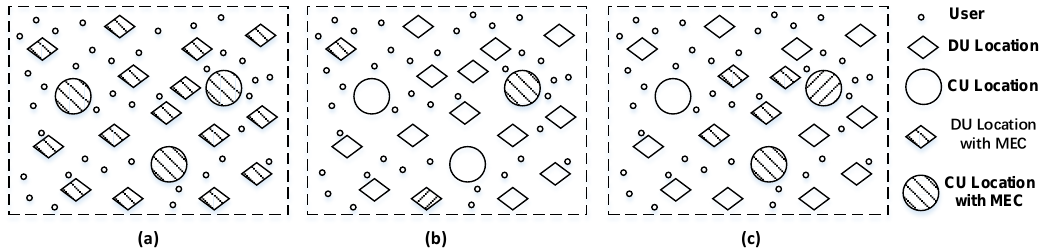
Figure 1. Different deployment solutions of mobile edge computing (MEC) servers in cloud radio access network (C-RAN) ( a ) Full deployment solution of MEC servers. ( b ) Low-cost decentralized deployment solution of MEC servers. ( c ) Centralized deployment solution of MEC servers.